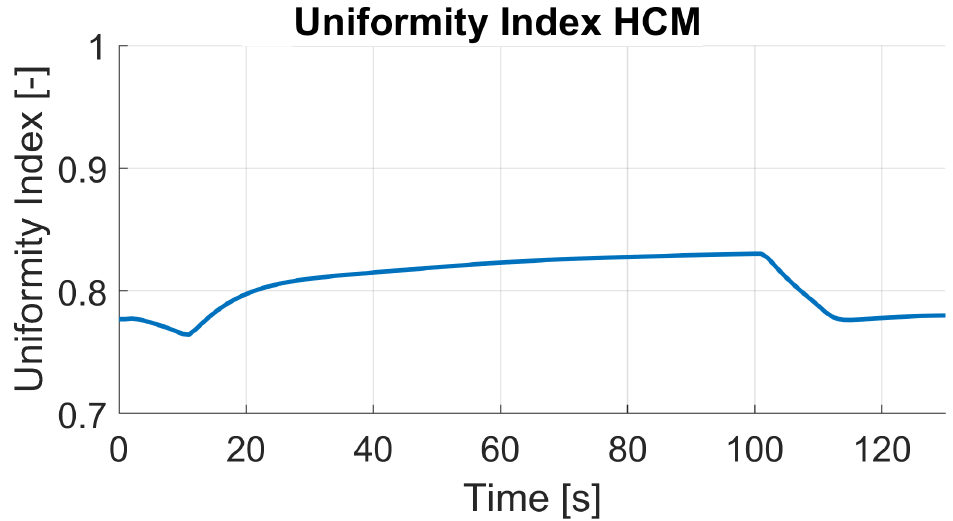
Figure 12. Uniformity index of dissolved water content in the membrane for load step L3 simulated with the